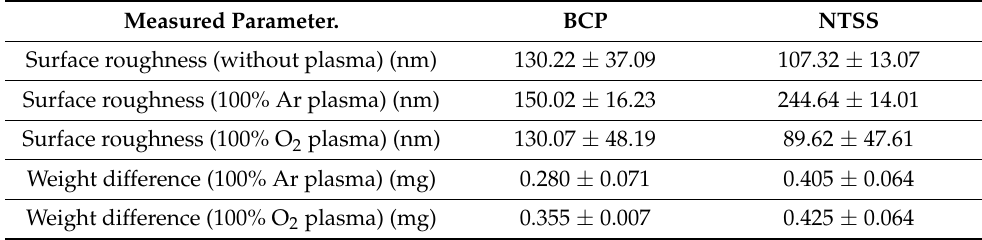
Table 3. Changes in roughness and weight of the film due to plasma activation. Measured